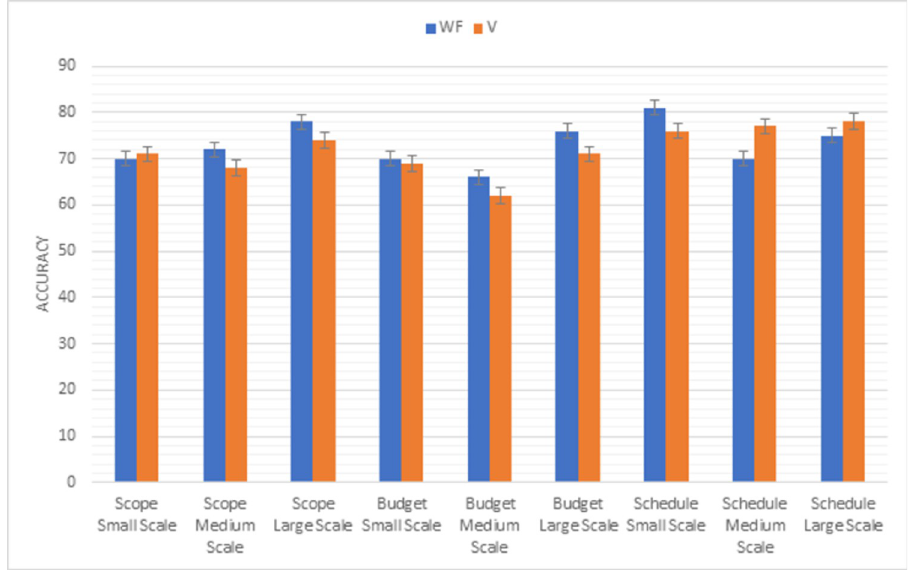
Fig 9. Graphical representation of waterfall vs V (first triangle)